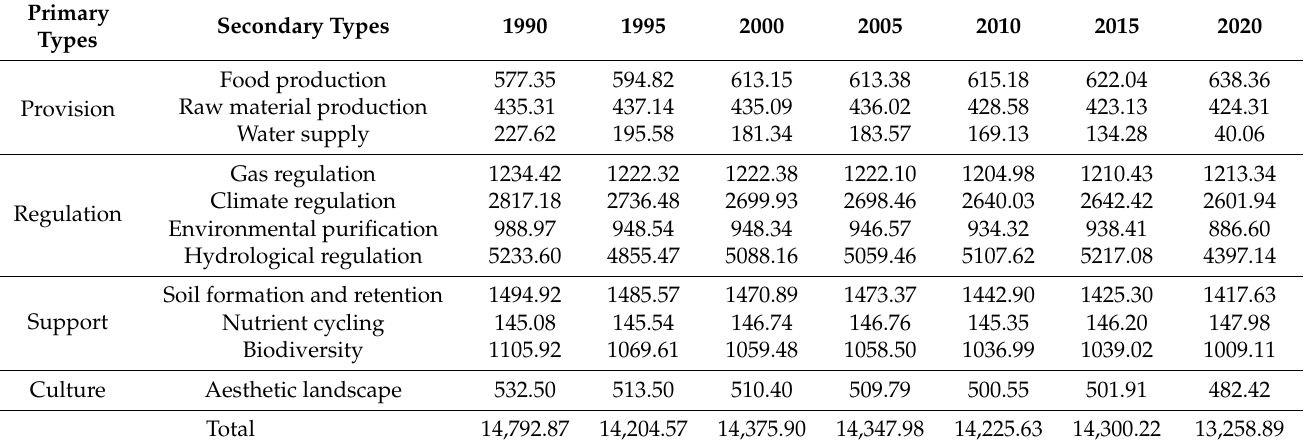
Table 4. ESV of different categories of ecosystem services from 1990 to 2020 (CNY 100 million).